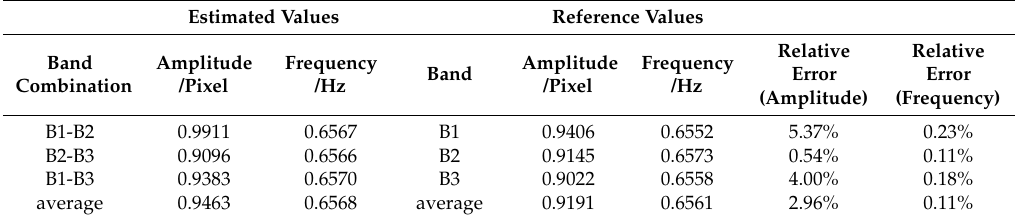
Table 6. Fitting residuals of absolute registration error curves of different bands.